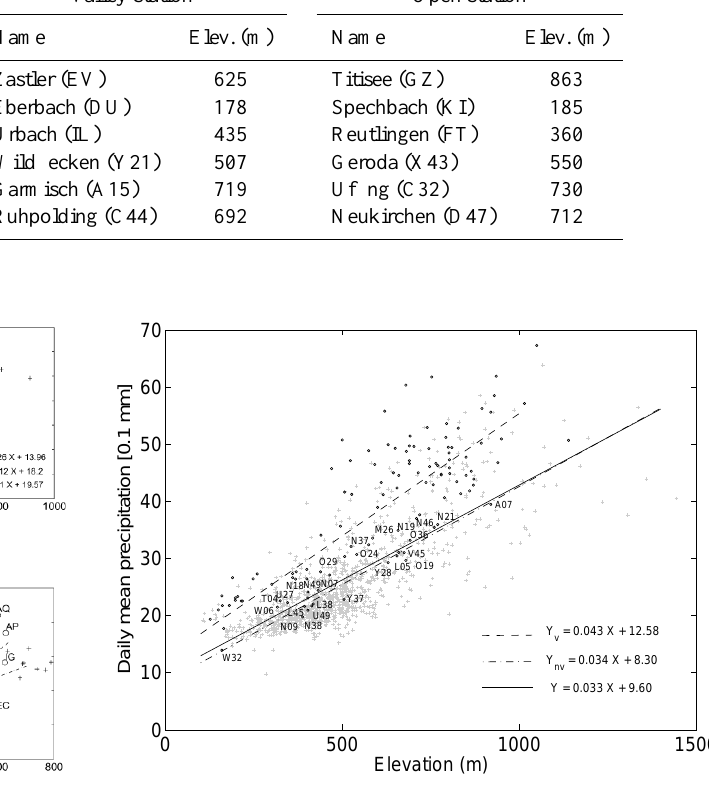
Fig. 10. Scatter plot of mean daily precipitation vs. elevation for BY (circles indicate valley stations, and crosses indicate non-valley stations, the trendlines are also shown in the